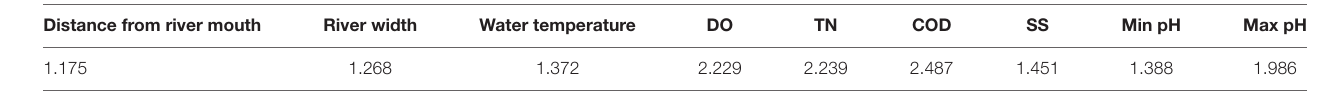
TABLE 1 | Summary of the variance inflation factor (VIF) analyses. Distance from river